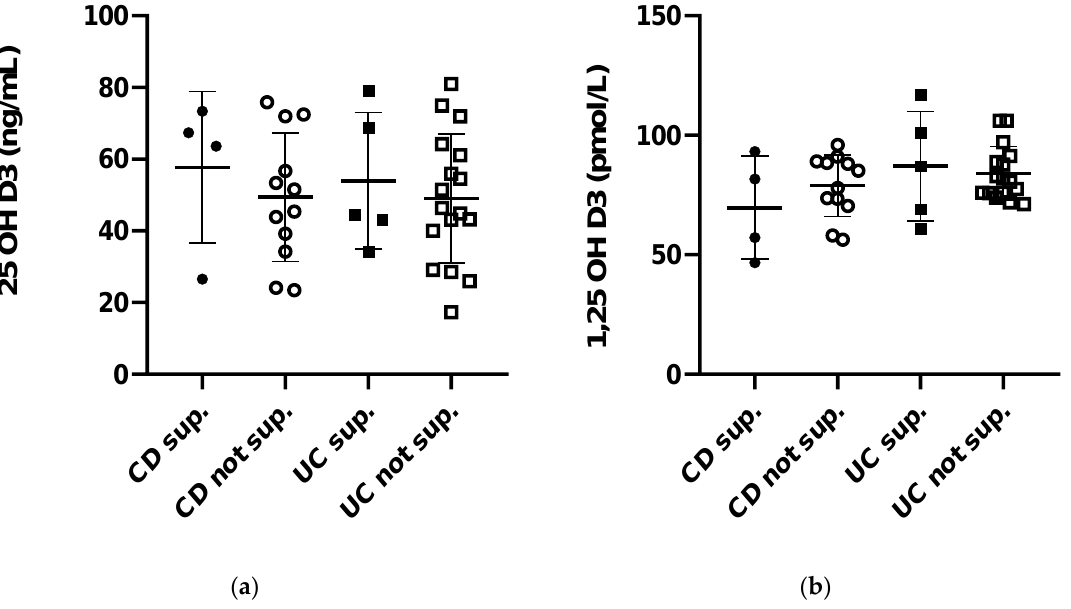
Figure 2. Serum concentrations of 25-hydroxy Vitamin D (25(OH) Vitamin D) ( a ) and 1,25-hydroxy Vitamin D (1,25(OH)2 Vitamin D) ( b ) in Crohn's disease (CD) and ulcerative colitis (UC) patients supplementing (sup.) or not supplementing (not sup.) vitamin D with over-the-counter (OTC) drugs.